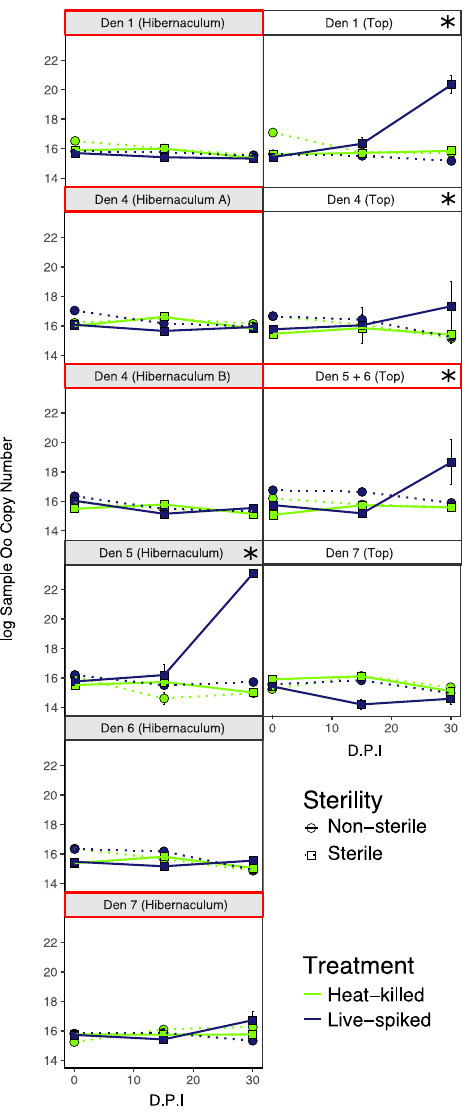
Figure 1. Growth curves of Ophidiomyces ophidiicola (Oo) in experimental microcosms. Plots in the right hand column represent topsoil samples; plots in the left hand column (grey header) represent hibernaculum soils. Red-header borders denote soils that were naturally qPCR positive for Oo. In order to aid interpretability of the plot, the Y-axis is the log of the qPCR target copy number of Oo present within each DNA extract. The X-axis is days post-inoculation (DPI). Microcosms spiked with heat-killed Oo are shown in chartreuse and those with live Oo in blue. Dashed lines connect those soils which were sterilized prior to inoculation and solid lines those which were not. Lines with an upward trajectory over time demonstrate an increase in Oo DNA (i.e., Oo growth). We determined Oo to have grown if there was greater than a 2 orders of magnitude difference between the mean Oo copy numbers of the heat-killed and live-spiked sample groups for a given soil and sterility treatment at a time point. Classified as such, growth of Oo was observable in four out of ten soils tested at 30 days post-inoculation (denoted by *). However, no growth was observed in any soils in which the native microbial community was left intact